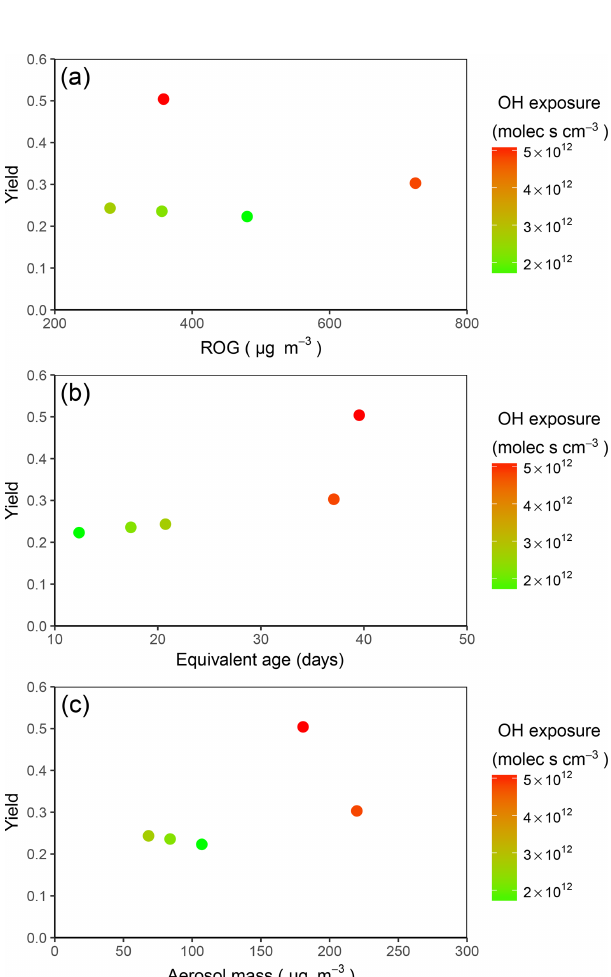
Figure 3. Measured D 5 oxidation aerosol yield as a function of (a) ROG (reacted D 5 ), (b) equivalent age assuming an OH concen- tration of 1.5 × 10 6 moleccm − 3 , and (c) aerosol mass. Data points are color coded according to OH